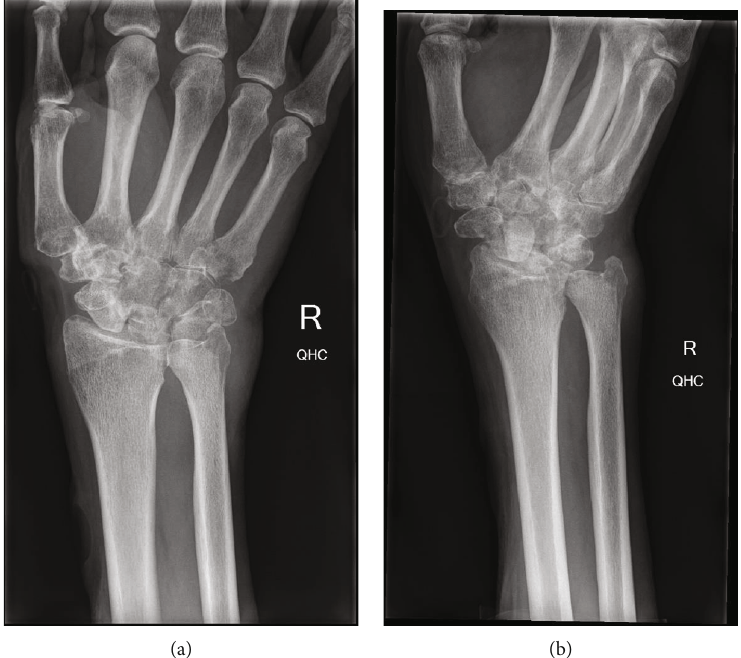
Figure 1: XR of the right hand post open synovectomy and biopsy: AP (a) and lateral (b) views. Erosive arthropathy at the intercarpal joints and carpometacarpal joints, with joint space narrowing within the radiocarpal articulation. Cortical erosion and reduced trabecular markings within the base of the 5 th metacarpal and ulnar styloid.